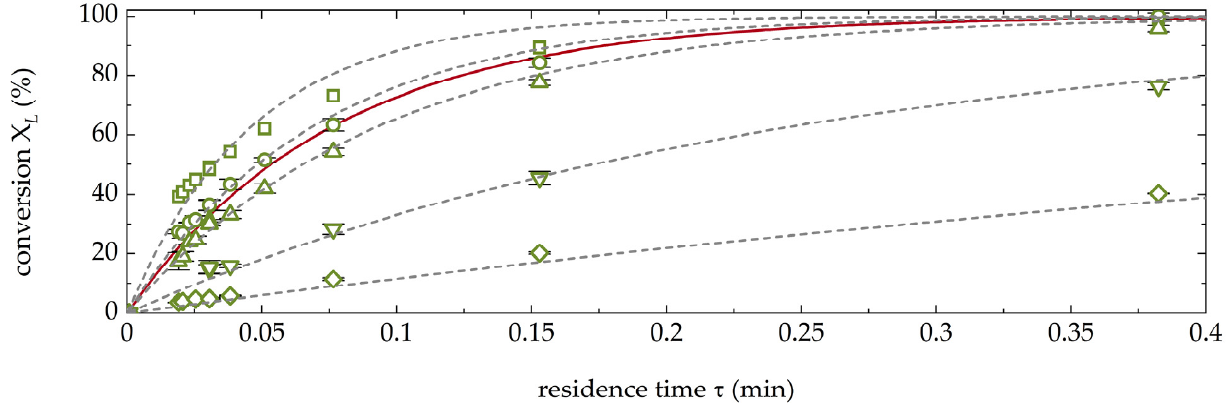
Figure 6. Conversion rates for different L -amino acids at 0.134 M in comparison with L -Met (solid red line): L -Lys (square), L -Arg (circle), L - Gln (upwards triangle), L -Ser (downwards triangle), and L -Asn (diamond).